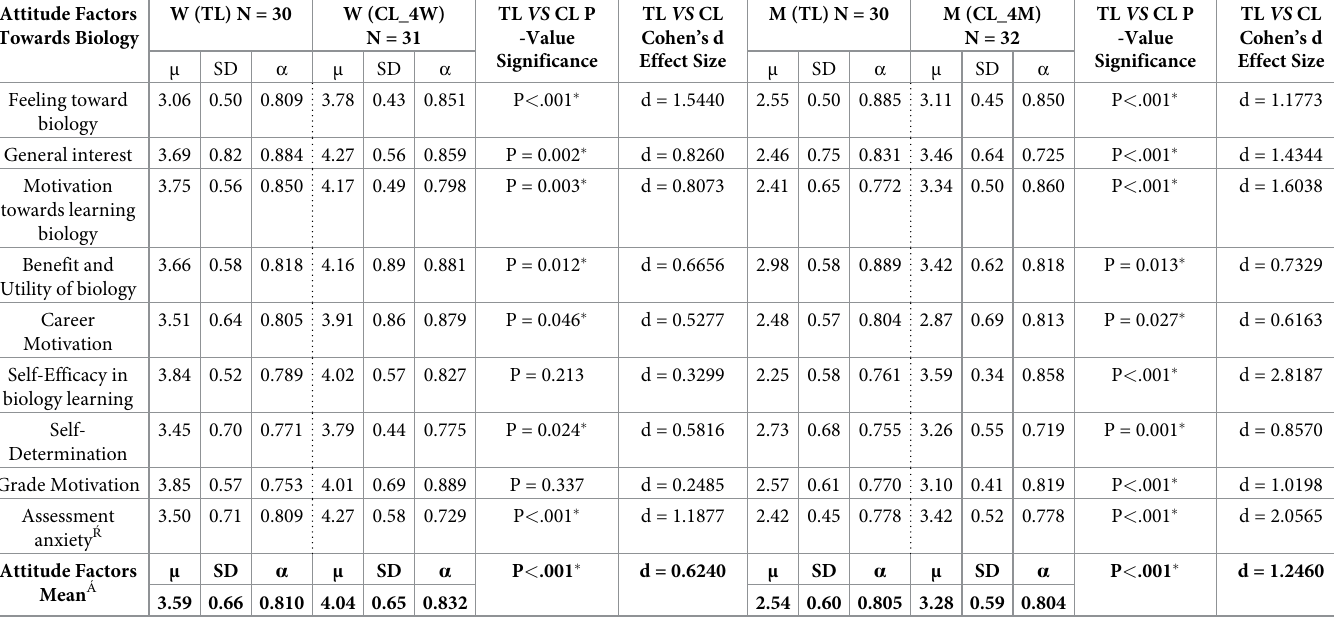
Table 2. Nonmajor single-gender biology students, means and standard deviations attitude scores for each attitude factor. Attitude Factors Towards Biology